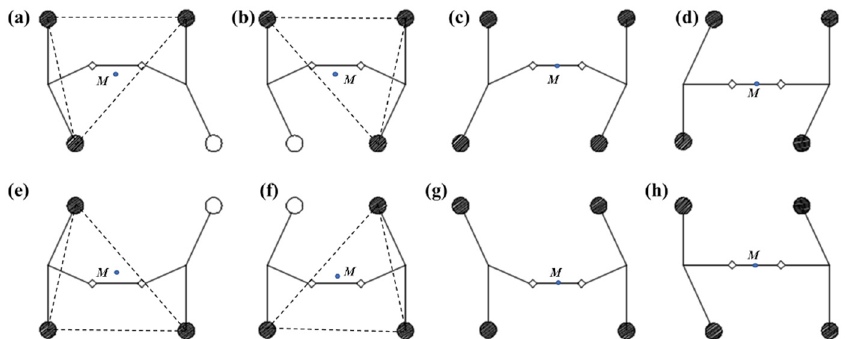
Figure 8. Tripod gait; ( a – h ) eight movements.